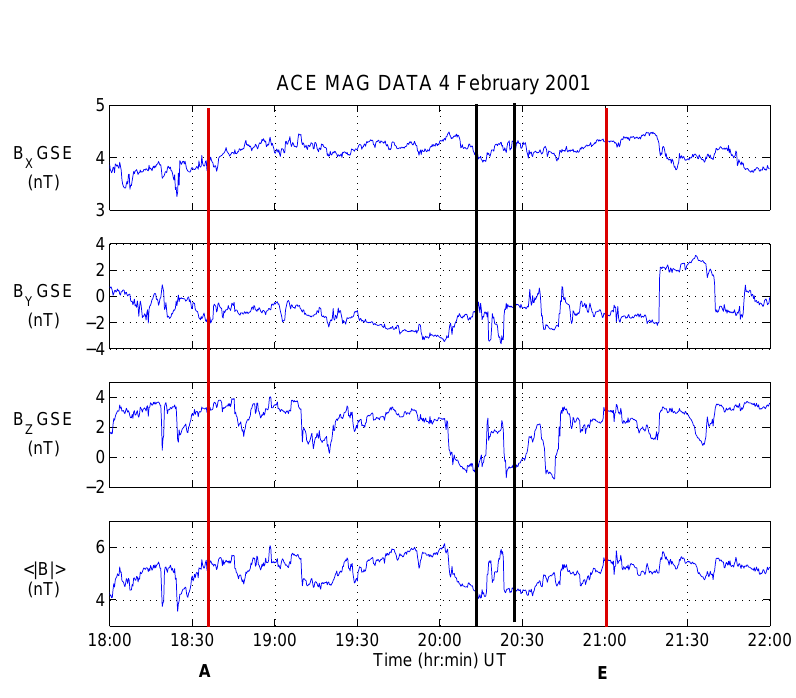
Fig. 7. A plot of the Top density mo- ments for each spacecraft, with Cluster 1 in the top panel, through to Cluster 4 in the bottom panel. The trace repre- sents the densities calculated from elec- trons detected above 1keV. Timing is carried out such that entry is indicated by a change in the gradient of the ramp seen before the main structure, as indi- cated by the arrows. A similar method is used for exit. The entry and exit se- quence is shown in Table 1. Figure 7